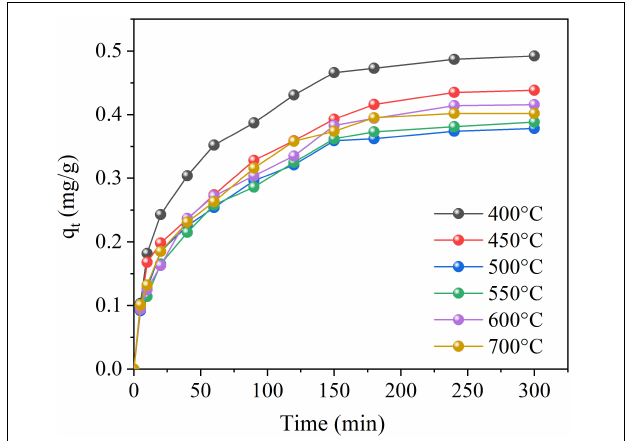
FIGURE 2 | Adsorption capacity at different calcined